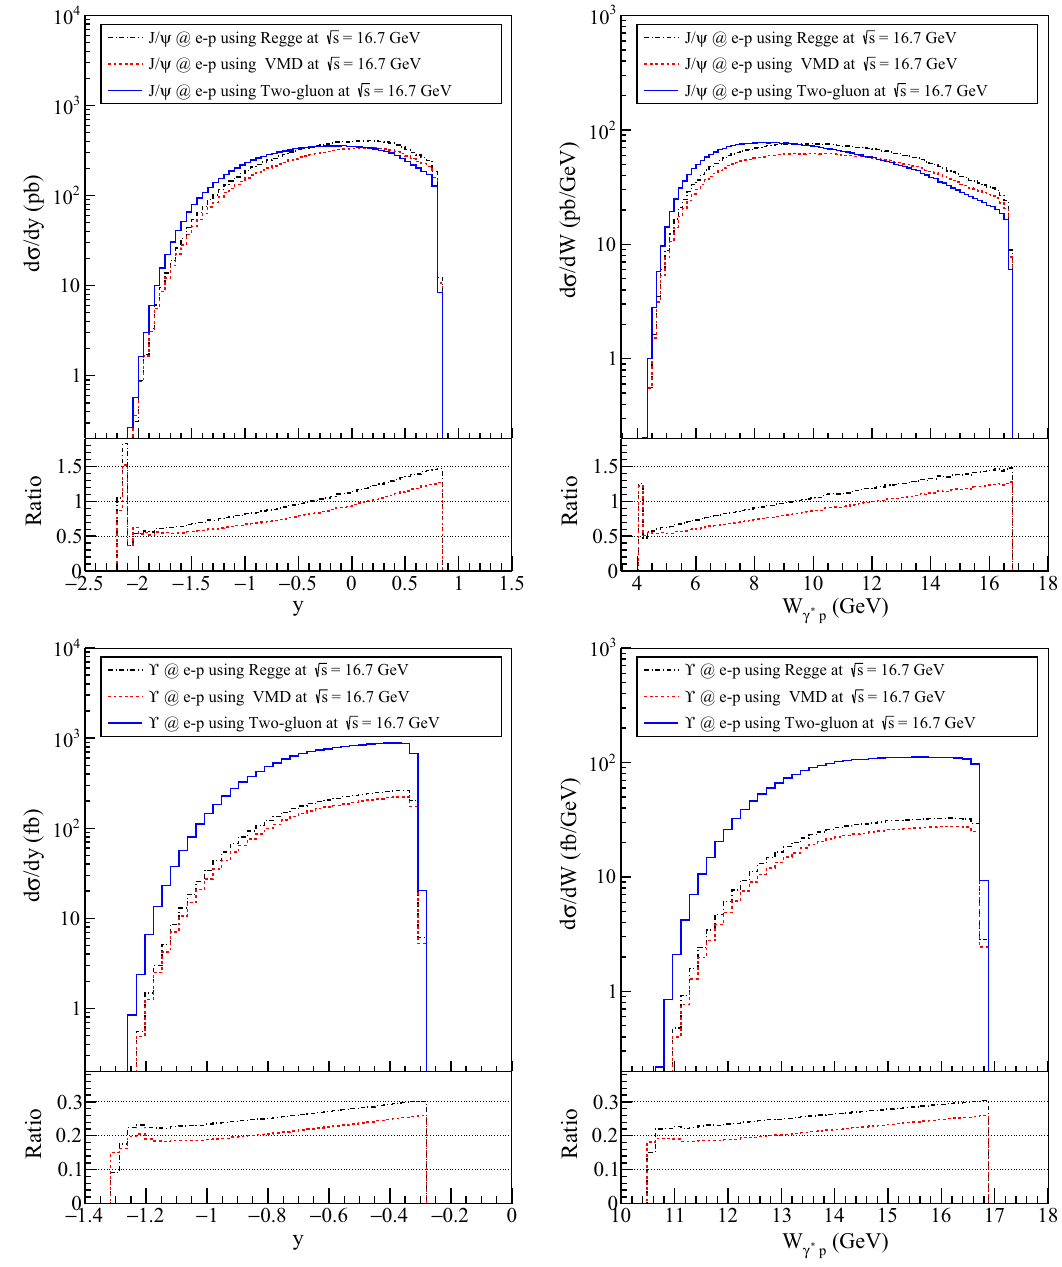
Fig. 4 Predictions for the rapidity (left panels) and W γ ∗ p (right panels) distributions associated to the exclusive J /(cid:2) (upper panels) and ϒ (lower √ s = 16 . 7 panels) photoproduction in ep collisions at the EicC (